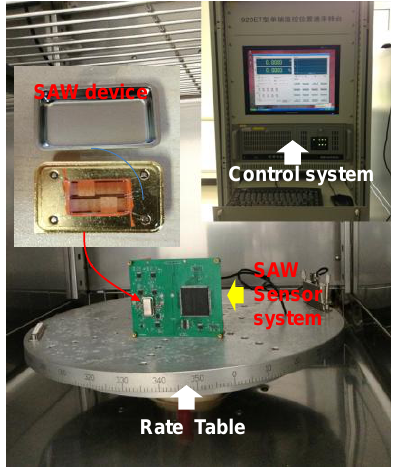
Figure 7. The measurement setup of the developed SAW rate